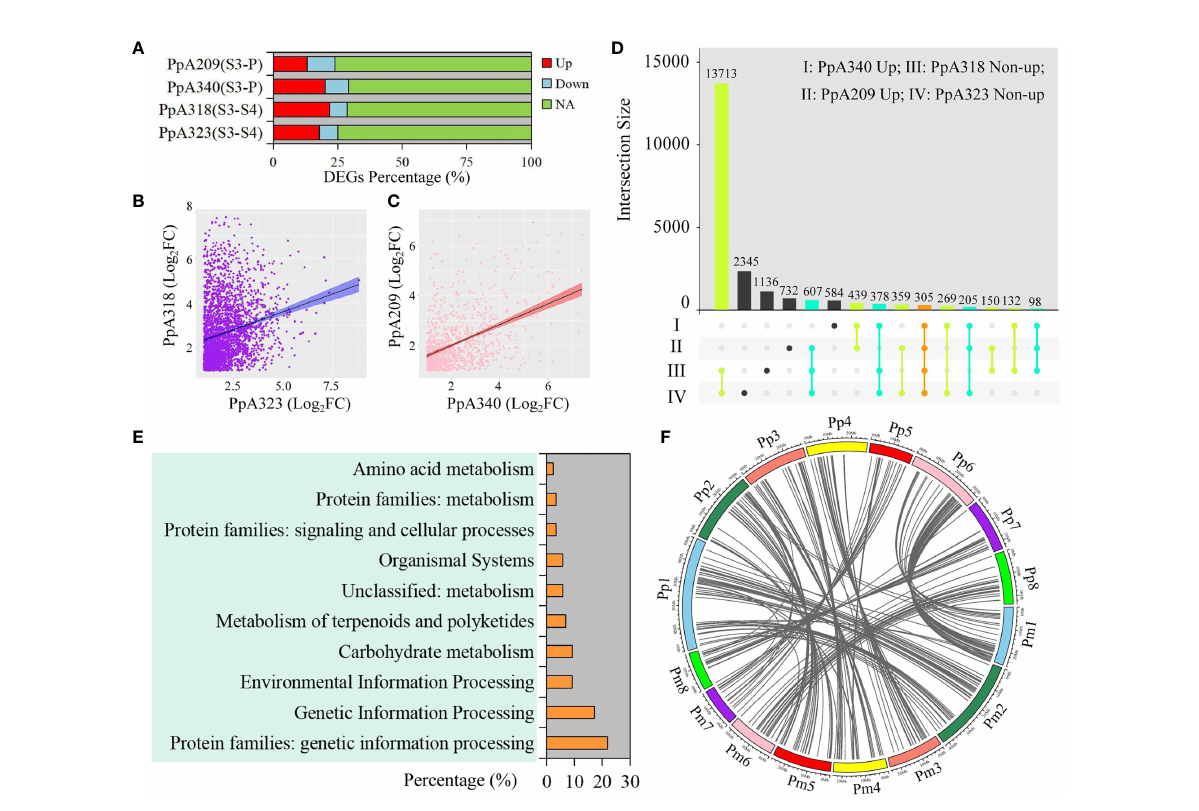
FIGURE 3 Identi fi cation and functional enrichment of early fl owering-related DEGs. (A) Percentage of DEGs at different stages in four P. persica genotypes (A209, A340, A318, and A323). (B) Correlation of DEGs between A318 and A323 from S3 to S4 stages. (C) Correlation of DEGs between A318 and A323 from S3 to P stages. (D) Comparison of genes between pre- fl owering stage in the A209 and A340 genotypes and dormancy stage in the A318 and A323 genotypes. Up represents upregulated DEGs, and non-up represents downregulated DEGs and genes with no signi fi cant difference change. (E) KEGG enrichment analysis of shared genes from (D) . (F) Collinearity genes of orthologous sequences with shared genes in P. persica and P. mume